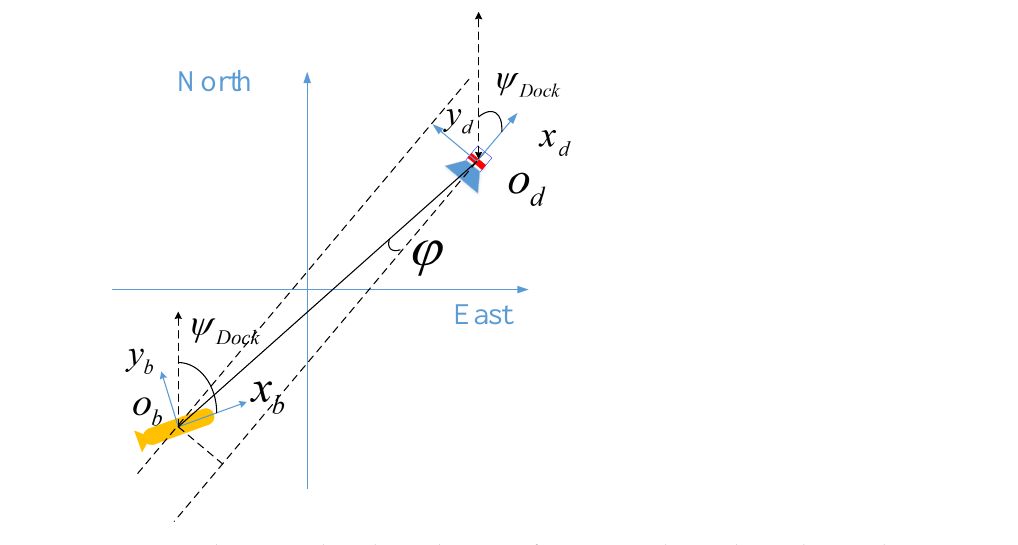
Receiver Figure 10. The prototype of the electromagnetic guidance system. Left and right are the electro- magnetic transmitter and receiver, respectively. 5.1. Electromagnetic Transmitter The electromagnetic transmitter includes the transmitting coil and its driving circuit. The radius of the coil is 100 mm, which is much smaller than the distance between the AUV and itself in terminal docking guidance, so the magnetic dipole model is applicable. A Litz wire with a line diameter of 1.5 mm is used to wind the transmitting coil. The pa- rameters of the transmitting coil are shown in Table 5. Table 5. Parameters of transmitting coil. Parameter